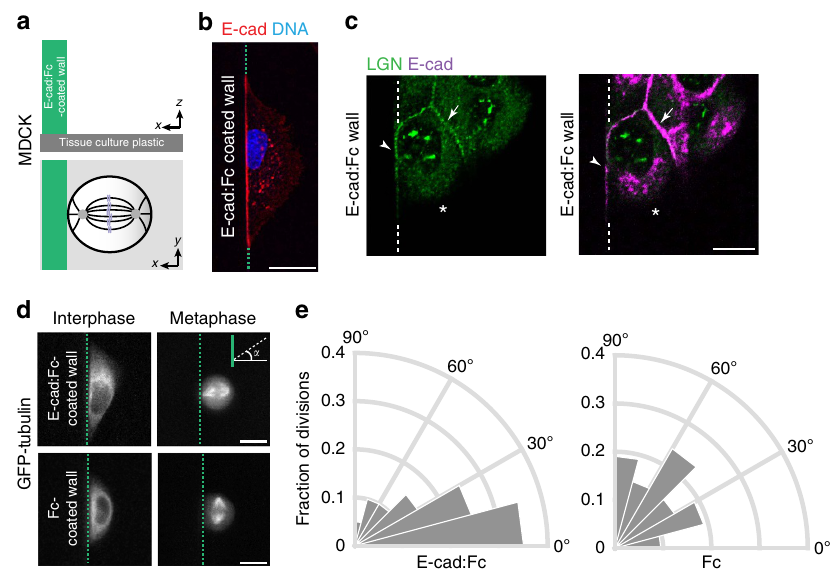
Figure 3 | An artificial E-cadherin cell–cell junction orients epithelial cell divisions. ( a ) Design of the E-cadherin:Fc sidewall in which a vertical silicone sidewall is coated with E-cadherin:Fc (E-cad:Fc) and the basal surface is uncoated. ( b ) Localization of E-cadherin:DsRed (E-cad) at the sidewall-cell junction in MDCK cells. ( c ) Immunostaining of endogenous LGN in cells associated with an E-cadherin:Fc sidewall, showing that LGN is recruited to the sidewall-cell junction marked with E-cadherin (arrowhead), similar to native cell–cell adhesions (arrow) in the monolayer, whereas LGN is absent from the free membrane (asterisk). ( d , e ) GFP-tubulin expressing MDCK cells associated with E-cad:Fc ( n ¼ 20) and Fc control ( n ¼ 21) sidewalls, with rose diagram quantification of the mitotic spindle angle relative to the sidewall. See Supplementary Fig. 3f for unbinned data. Scale bars, 10 m m. Quantified data were pooled from four independent